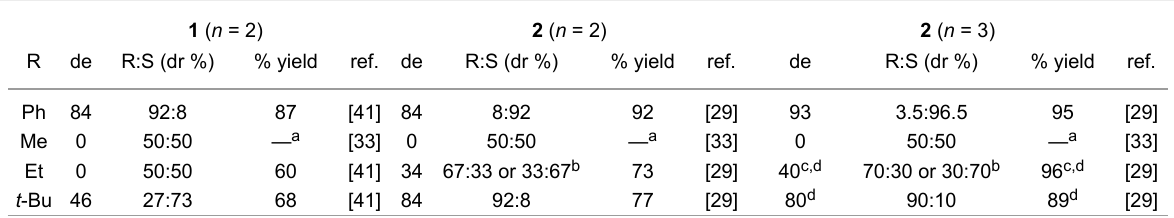
Table 4: Characteristics of major products from reactions of 1 and 2 with alkenols in Scheme 2 at − 78 °C. 1 ( n = 2) 2 ( n = 2)